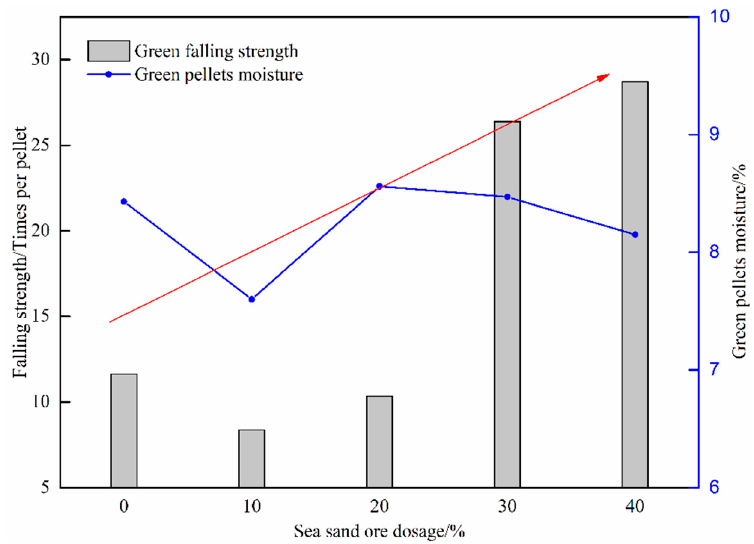
Figure 5. Falling strength and moisture of green pellets with different dosages of sea sand ore.